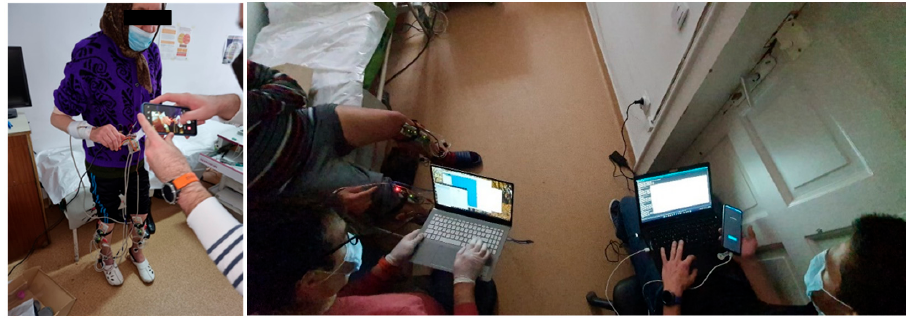
Figure 10. Photographs taken during the trials of gait assessment.